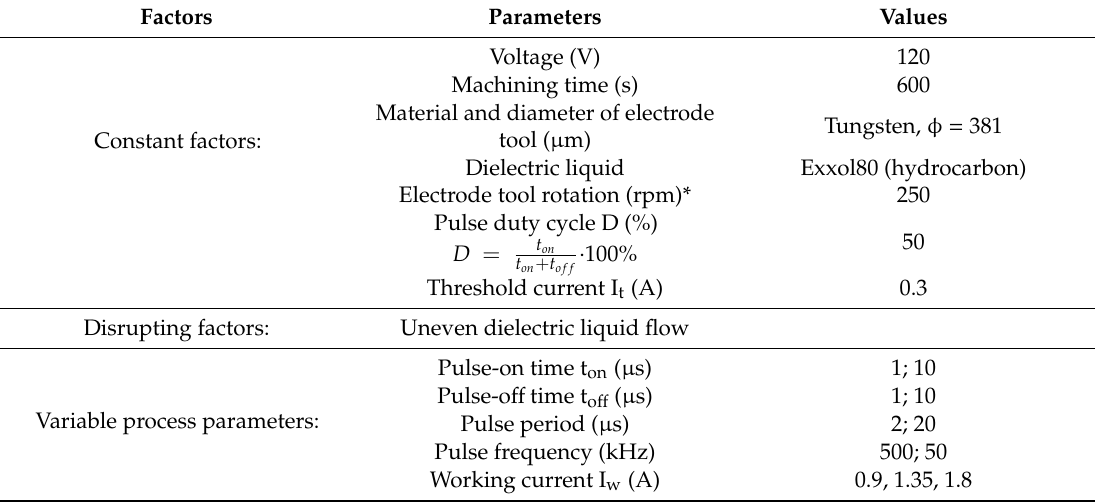
Table 1. Input factors for the experiment.